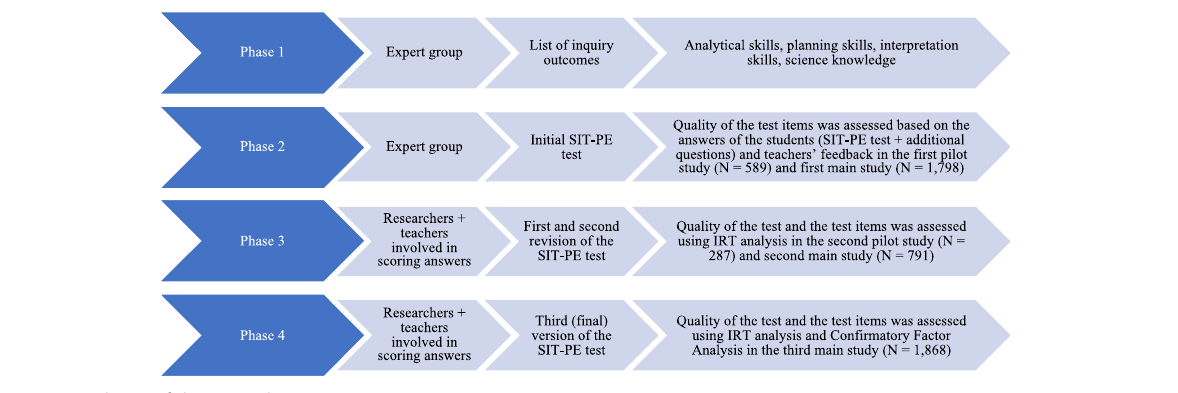
Fig. 1 Four phases of designing the SIT-PE test